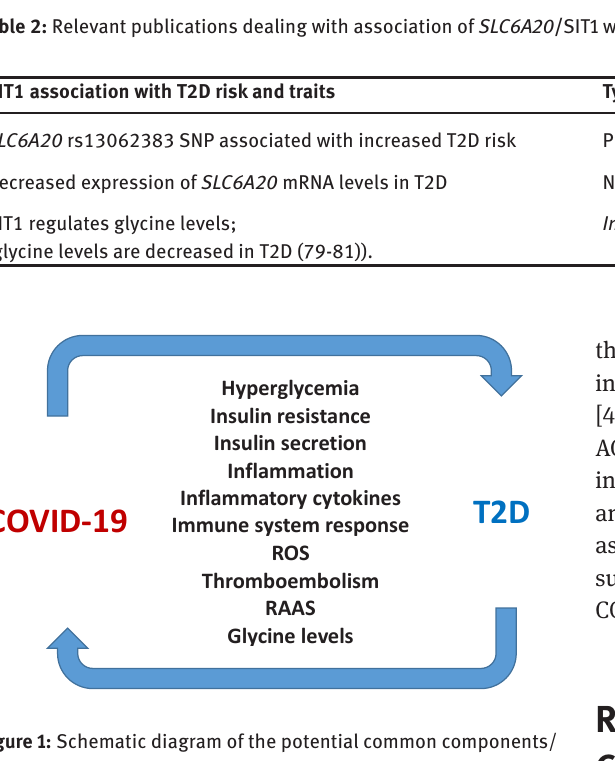
Figure 1: Schematic diagram of the potential common components/ mechanisms involved in pathogenesis of both, coronavirus disease 2019 (COVID-19) and Type 2 diabetes mellitus (T2D). COVID-19